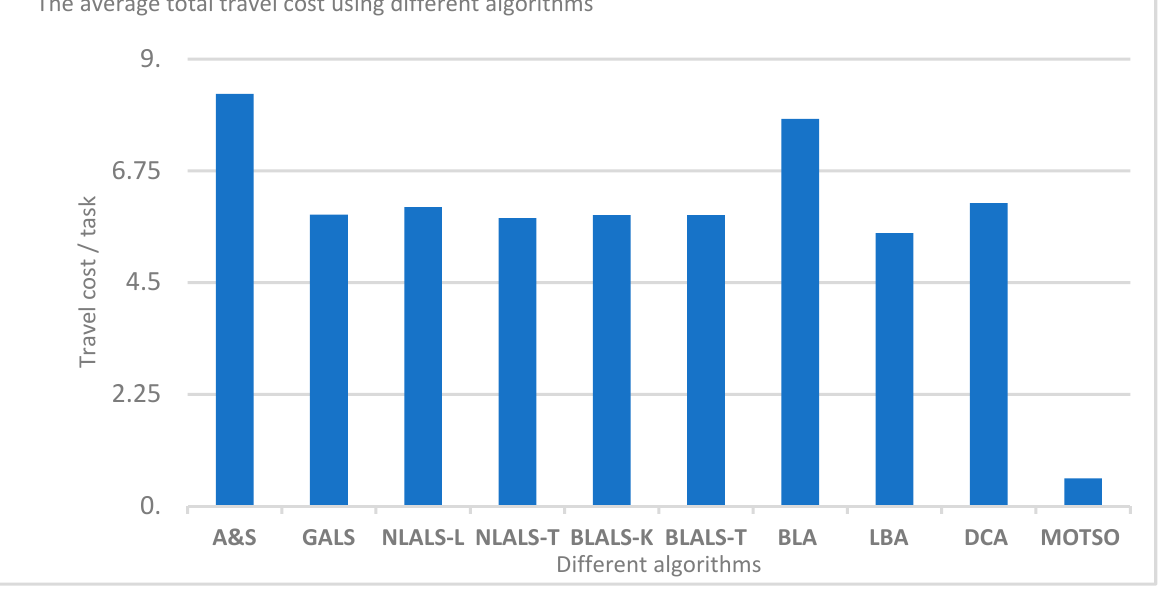
Figure 8. The average total travel cost using different algorithms.